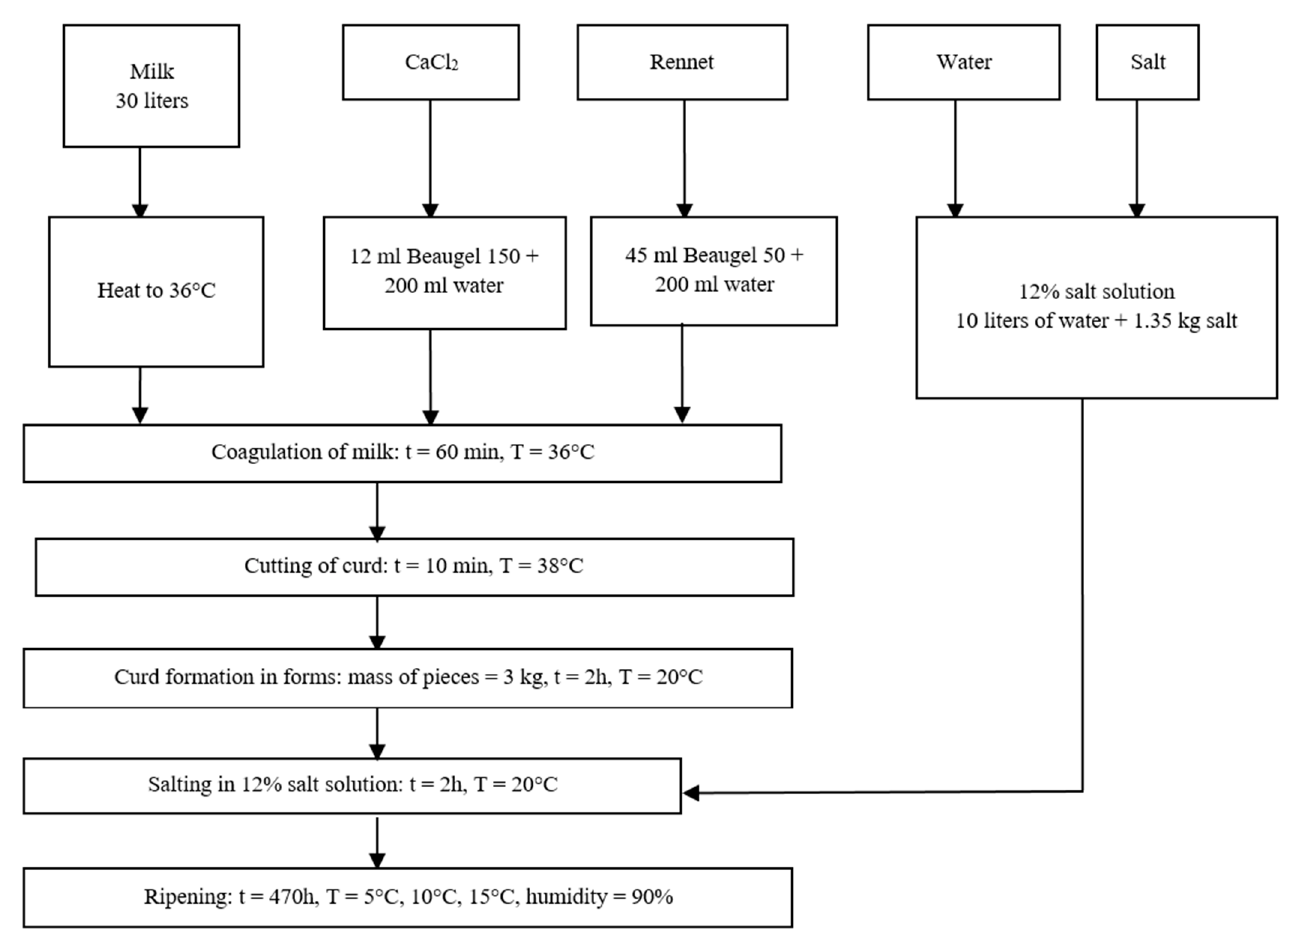
Figure 3. Technological procedures and process conditions in the production of laboratory-scale Koryci´nski